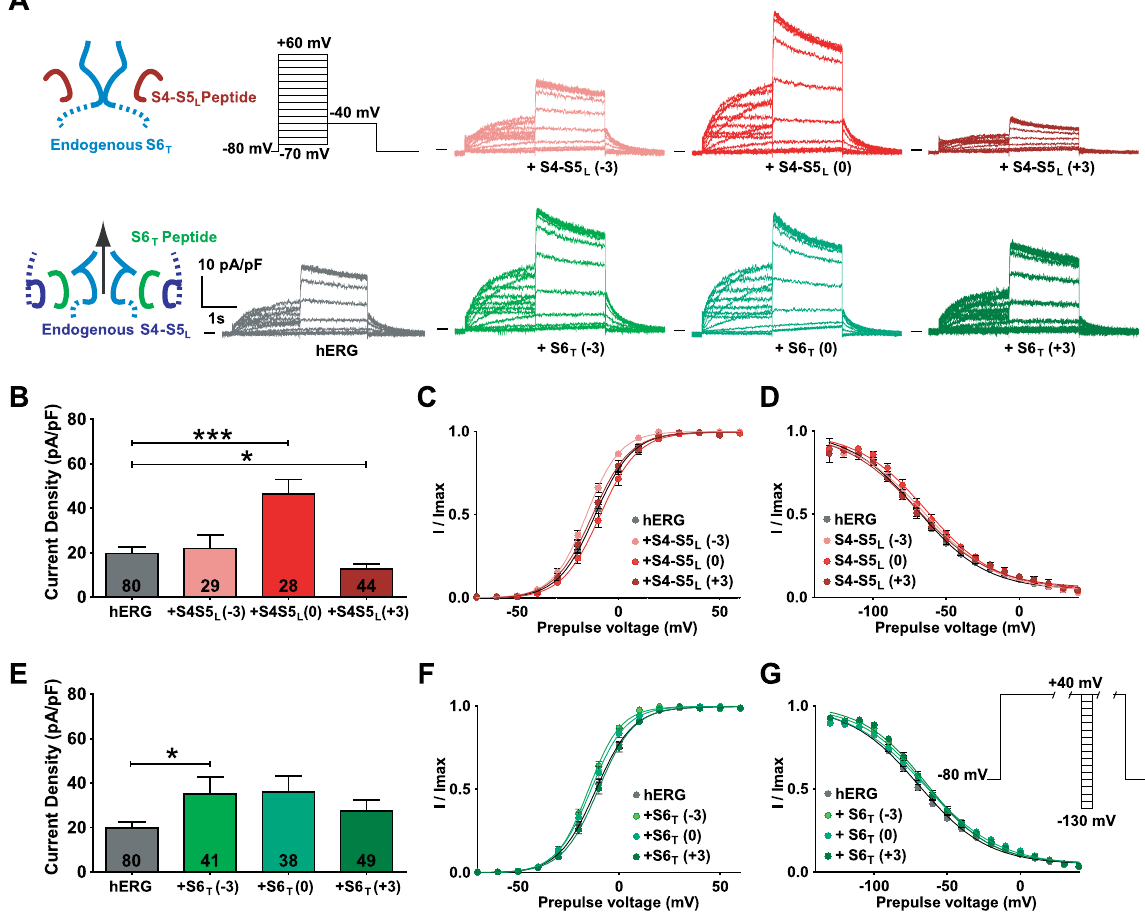
Figure 2. S4-S5 L ( + 3) peptide inhibits and S6 T ( − 3) peptide activates hERG channels. ( A ) Representative, superimposed recordings of the WT hERG current in the absence (0.6 µ g hERG plus 1.4 µ g GFP plasmids) and in the presence of S4-S5 L or S6 T peptides (0.6 µ g hERG plus 1.4 µ g peptide plasmids). Left: schemes of the hypothetical effects of S4-S5 L inhibiting or S6 T activating peptide; activation voltage protocol used (one sweep every 8 s) located above the WT hERG currents; right: data from experiments performed in the presence of various S4-S5 L or S6 T peptides. ( B ) Mean hERG tail-current density at − 40 mV after a prepulse at + 60 mV in the presence of S4-S5 L peptides. ( C) Activation curve, obtained from tail currents using the protocol shown in A, in the presence of S4-S5 L peptides (n = 21–65). ( D ) Inactivation curve in the presence of S4-S5 L peptides (n = 6–24). Inset, Inactivation voltage protocol used (one sweep every 5 s, first pulse = 1 s, second pulse = 15 ms, third pulse = 0.5 s). ( E ) Through ( G ) same as B through D, in the presence of S6 T peptides (F, n = 28–65; G, n = 15–24). * p < 0.1, *** p < 0.01 versus control hERG, Mann-Whitney